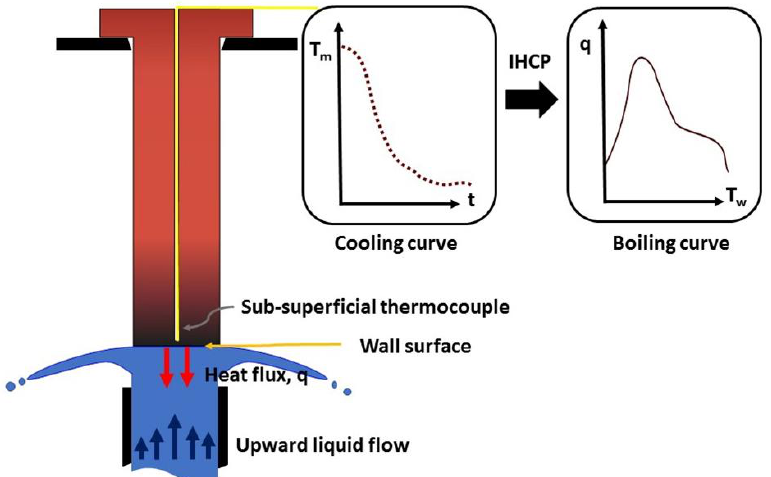
Figure 1. Graphic summary of the boiling curve determination from a cooling curve and using the solution of the IHCP. The workpiece is an instrumented steel cylinder for the end-quenched Jominy